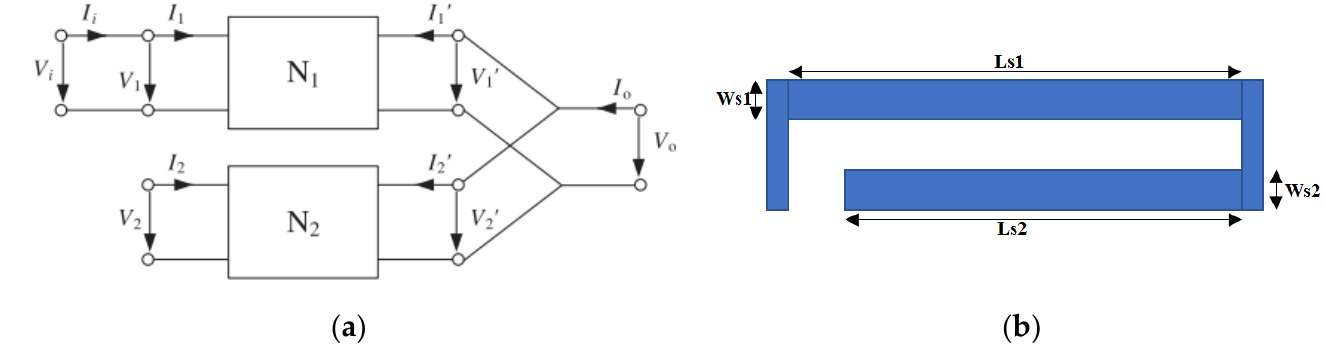
Figure 4. ( a ) Proposed spur line configuration. ( b ) Equivalent configuration of the spur line. After the termination condition is applied to Equation (5) in [30], the four-port network becomes a two-port network. Therefore, the chain matrix is also called the ABCD matrix for the equivalent structure, having characteristic impedances Z 3 and Z 4